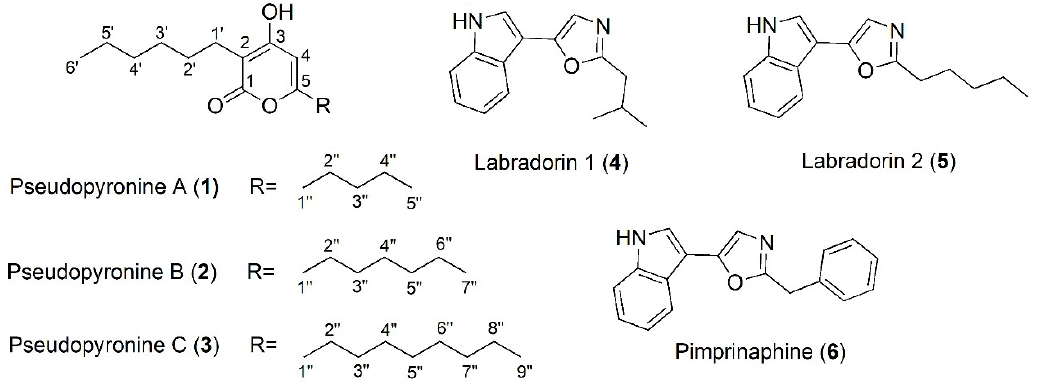
Figure 1. Structures of compounds 1 – 6 , isolated from P. mosselii P33.